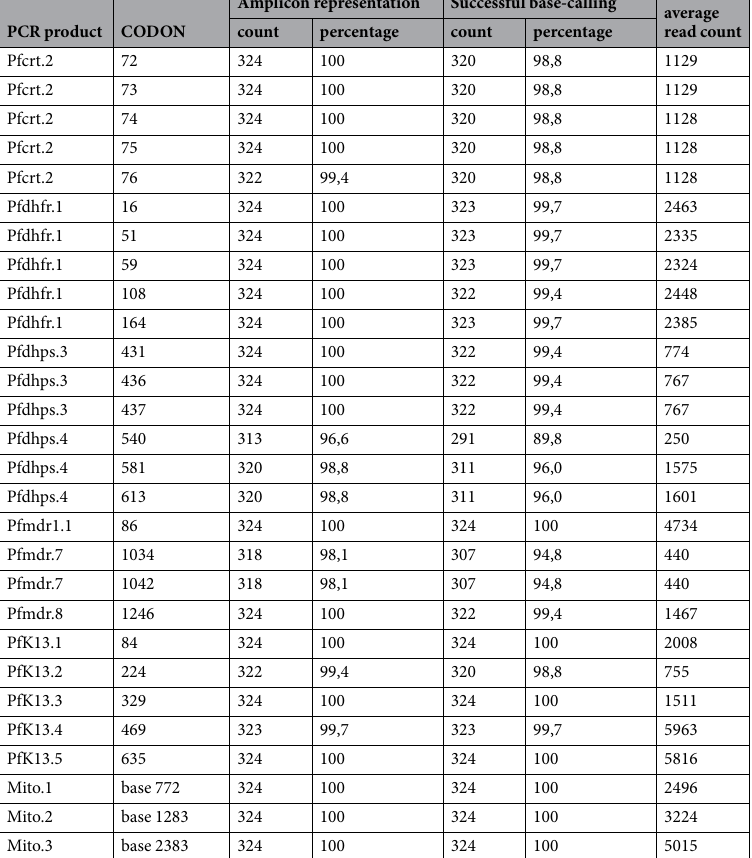
Table 1. Amplicon Amplicon representation, successful base calling and average read count. The table shows how many of the samples were found with pertaining reads corresponding to the various amplicons, after quality trimming (as sample count and percentage), as well as for how many samples successful base-calling was performed (requires a minimum z-score of 1.96). For pfK13 and for the mitochondrion, a position for each amplicon was analysed. Some of the SNP positions are located in the same amplicon. The table also lists the name of the individual amplicons, and Fig. 3 can be referred to for illustrations of the length and position of the amplicons within the various